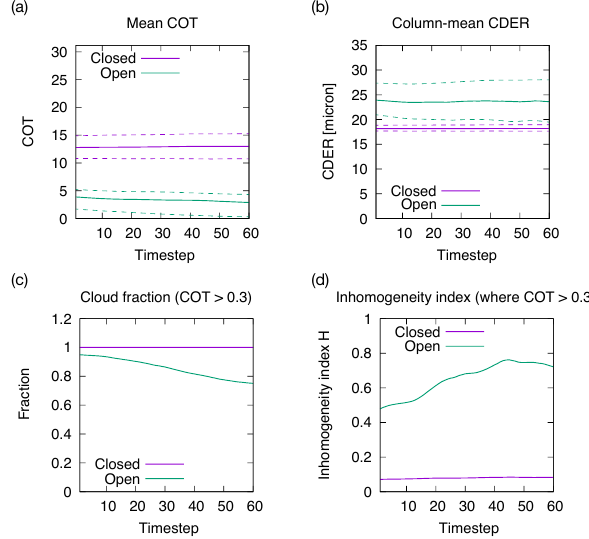
Figure 2. Temporal variations of (a) COT, (b) column-mean CDER, (c) cloud fraction, and (d) inhomogeneity index H . Solid lines shows mean values, and dashed lines show the 25th and 75th per- centiles. The cloud fraction and H are computed for pixels with COT > 0.3. A time step corresponds to